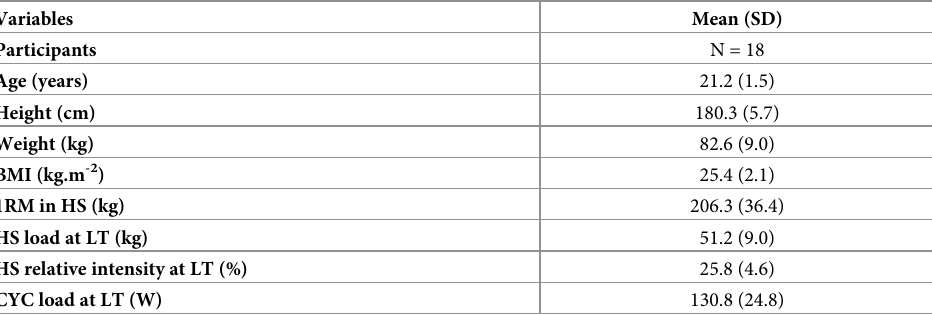
Table 1. Descriptive data related to anthropometric characteristics, 1RM- and incremental-load